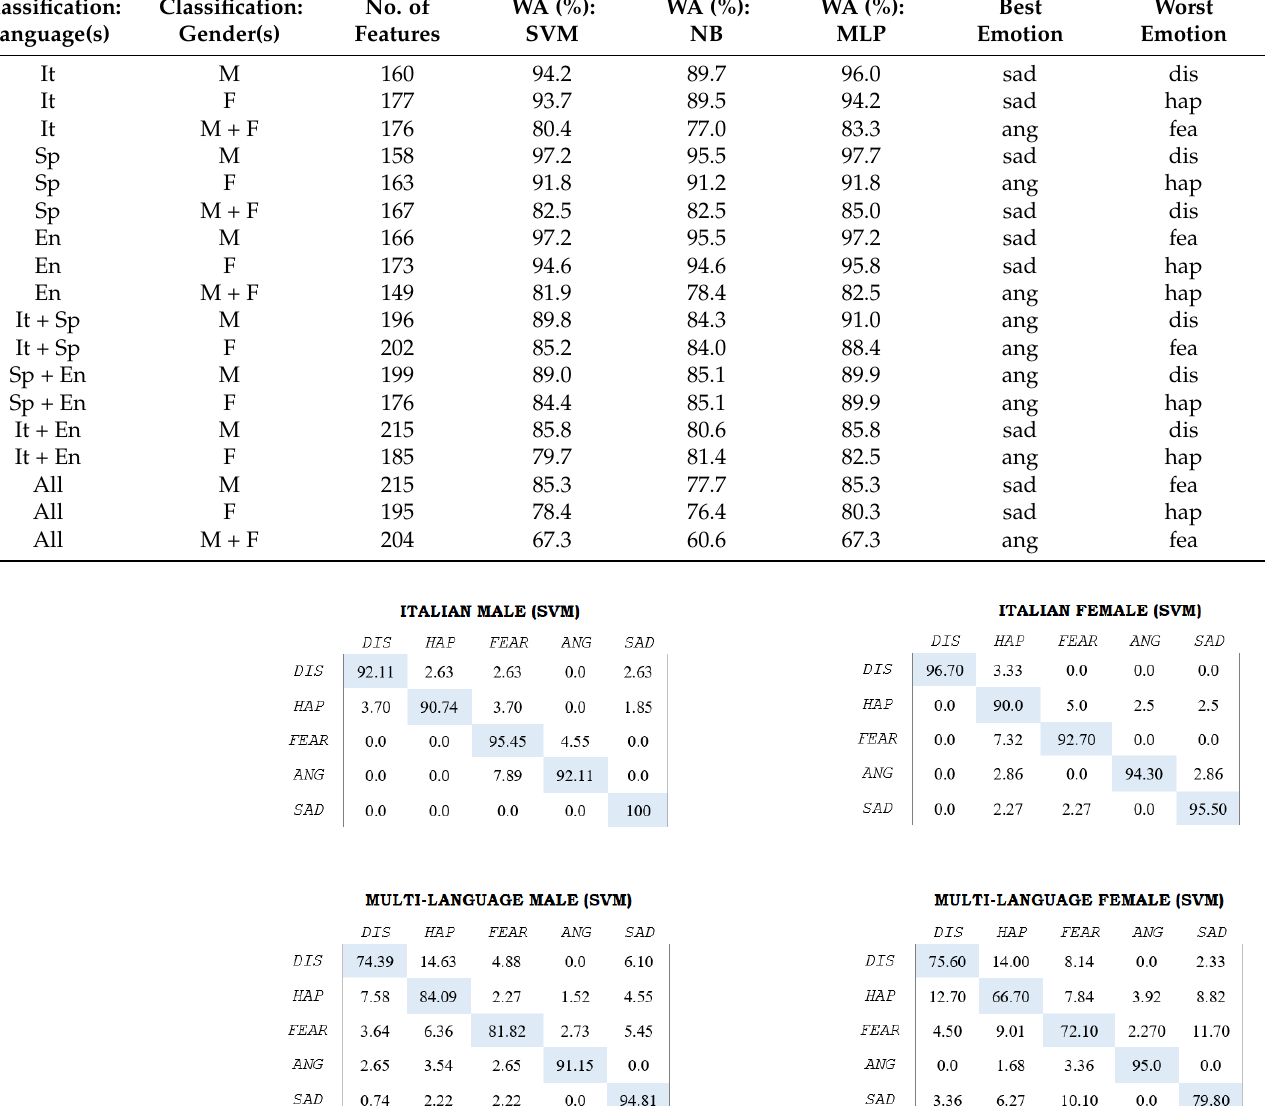
Table 3. Classification performances in terms of weighted accuracy. Emotion labels are thus abbrevi- ated: “DIS” = Disgust; “HAP” = Happy; “FEAR” = Fear; “ANG” = Angry; “SAD” = Sad. “Best” and “Worst emotion” refer to the most and least accurate classes.